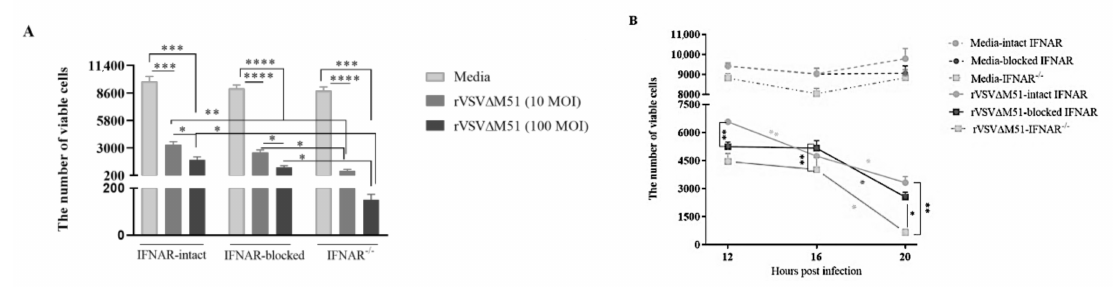
Figure 6. Type I interferon receptor (IFNAR) signaling protected murine bone-marrow-derived mast cells (BMMCs) from recombinant vesicular stomatitis virus (rVSV ∆ m51)-induced cell death. IFNAR-intact, IFNAR-blocked, and IFNAR-knockout (IFNAR − / − ) BMMCs were infected with rVSV ∆ m51 at a multiplicity of infection (MOI) of 10 or 100. Twelve, 16, and 20 h later, the cells were stained for the surface markers Fc ε RI α and c-kit. A cell viability dye was used to discriminate live and dead BMMCs by flow cytometry. Graphs show means and standard deviations pooled from four (IFNAR-intact and IFNAR-blocked BMMCs) or six (IFNAR − / − BMMCs) experimental replicates of the number of viable cells among Fc ε RI α + c-Kit + mast cells at ( A ) 20 h post-infection with 10 or 100 MOI of the virus and ( B ) at 12, 16, and 20 h post-infection with 10 MOI of the virus. Two-way analysis of variance with Tukey’s multiple comparison test was used to define statistical significance as * p < 0.05; ** p < 0.001; *** p < 0.0005; **** p <